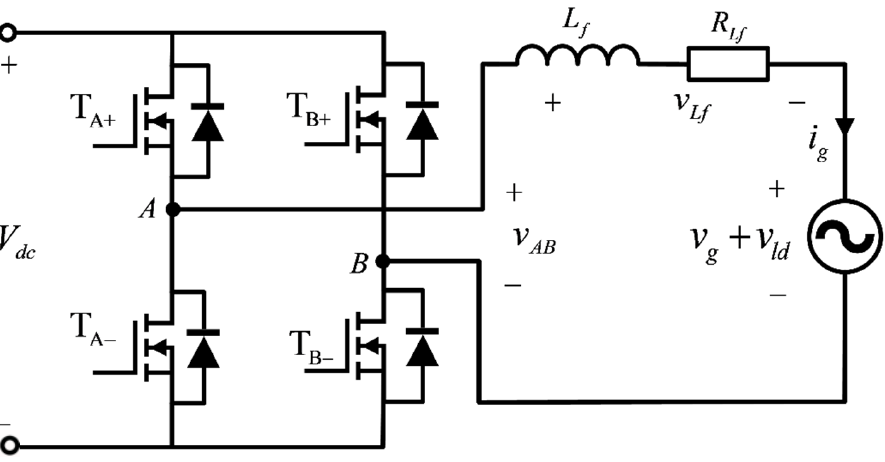
Figure 1. Framework of grid-connected inverter.